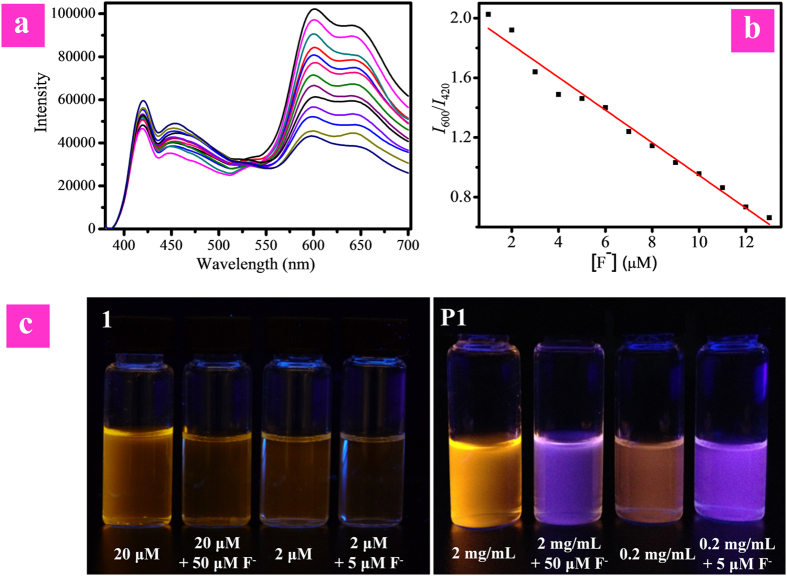
(a) PL spectra of P1 in PBS (pH = 7.4) with addition of F− from 0 to 13 μM upon excitation at 365 nm. (b) I600/I420 as a function of [F−] and its trendline. (c) Photographs of complex 1 in CH3CN and polymer P1 in PBS solution under excitation at 365 nm.